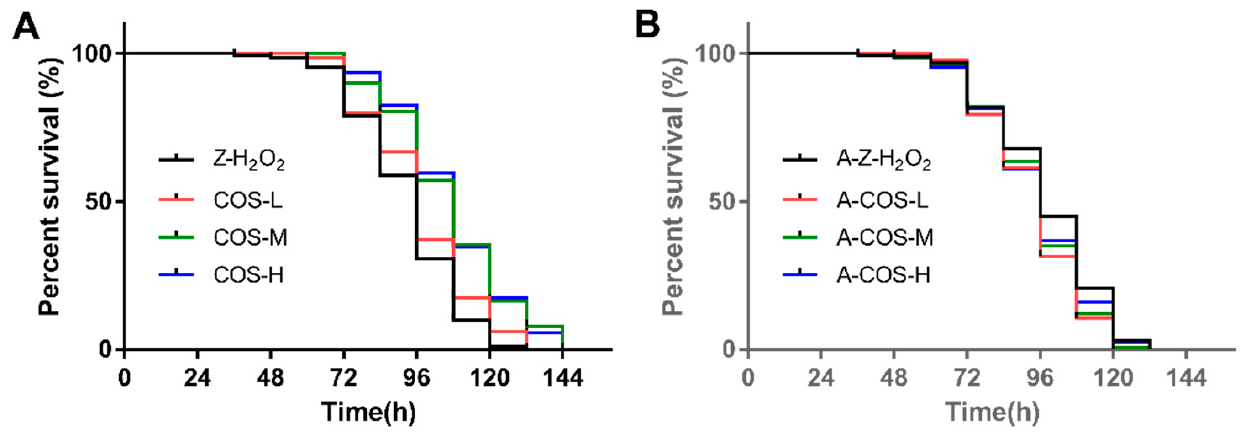
Figure 1. The survival curve of H 2 O 2 -induced female Drosophila with different feeding: ( A ) normal fruit flies, ( B ) axenic fruit flies.